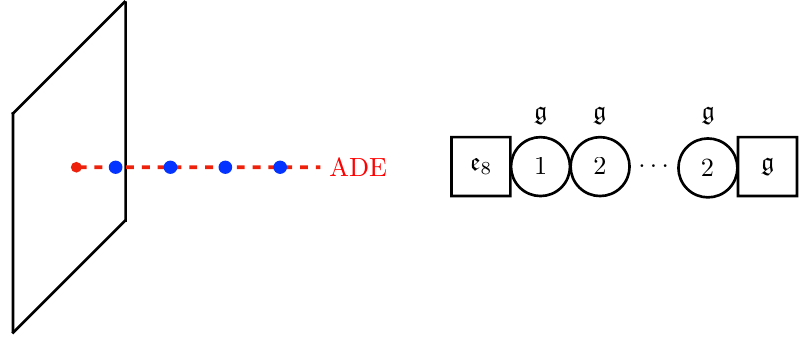
Figure 3 . Realization of the orbi-instanton theory in M-theory on the partial tensor